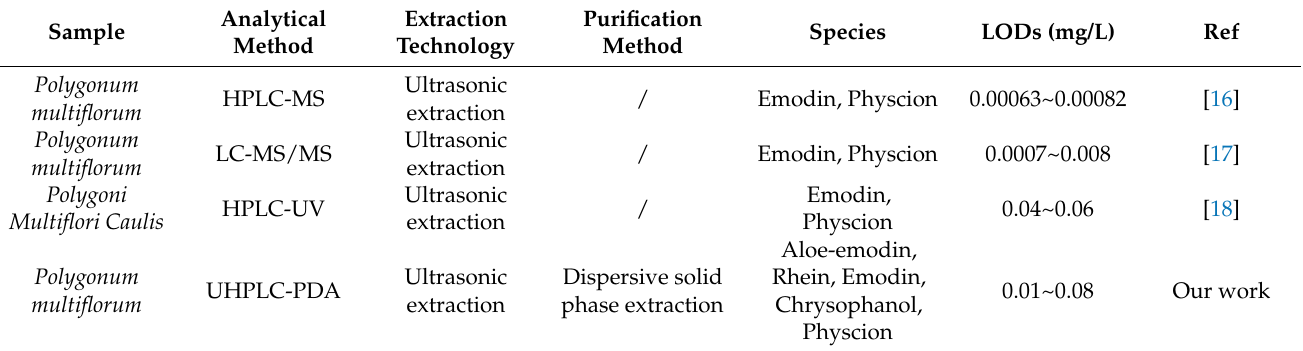
Table 6. A comparison of reported methods with our